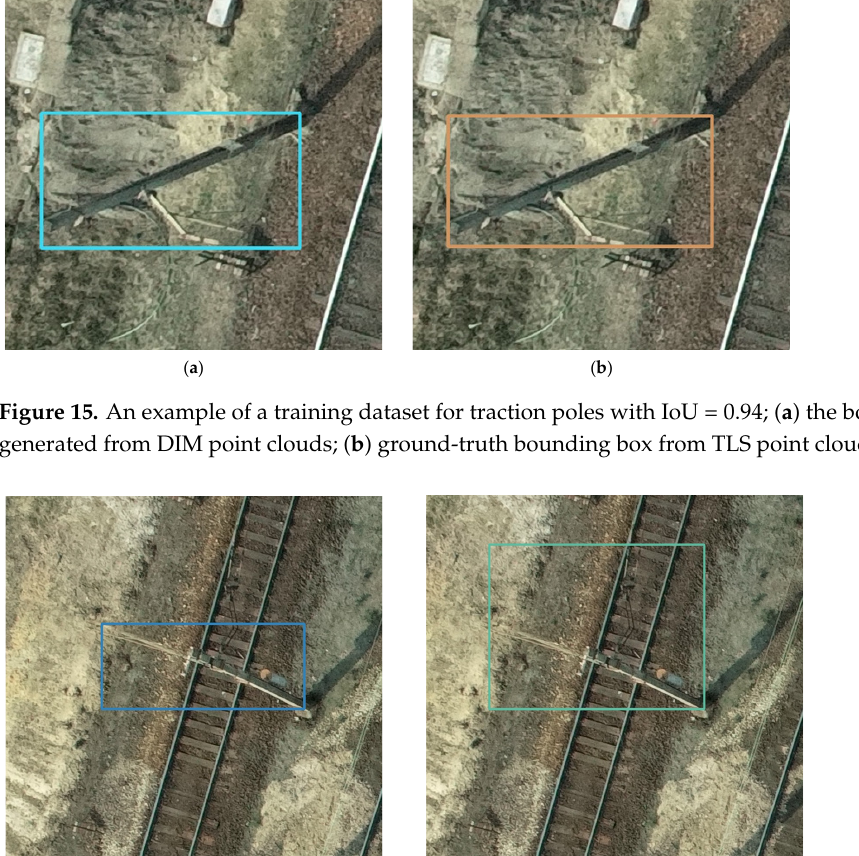
Table 8. Accuracies of the resulting bounding boxes for the traction poles for fourteen point cloud variants. The table values are the average IoU (Intersection over Union) multiplied by 100%, which is the evaluation metric.